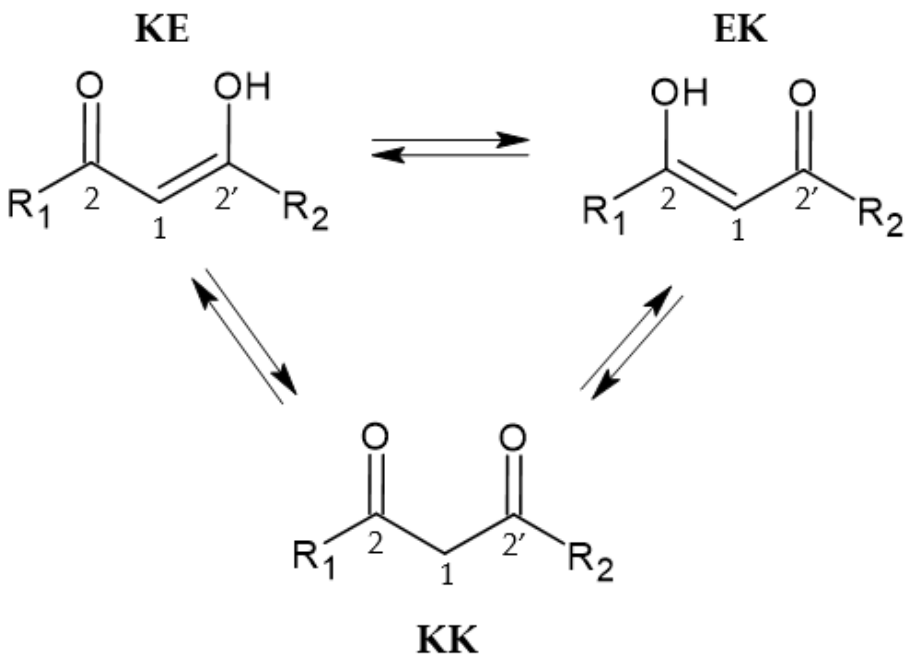
Figure 3. Schematic representation of tautomeric